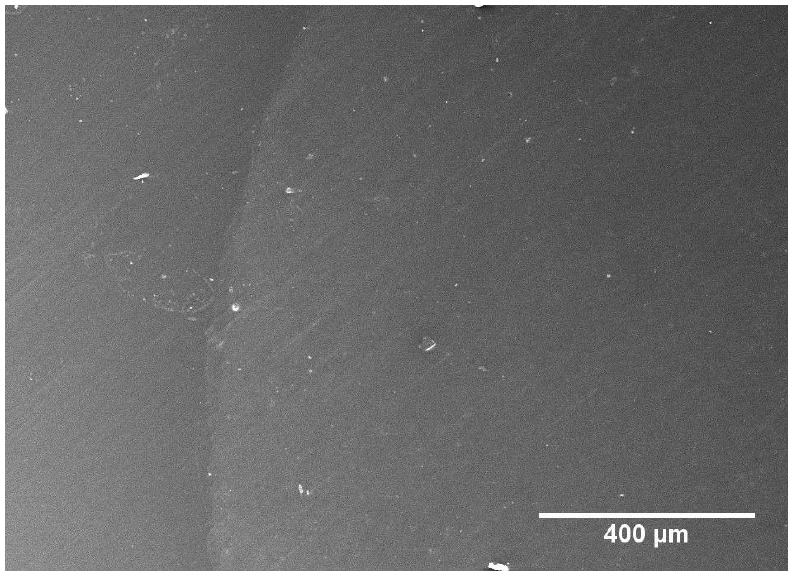
Figure 4. SEM micrograph of continuous margin (group 9; Clearfil SE Bond with 10 s phosphoric acid etching in demineralized enamel).